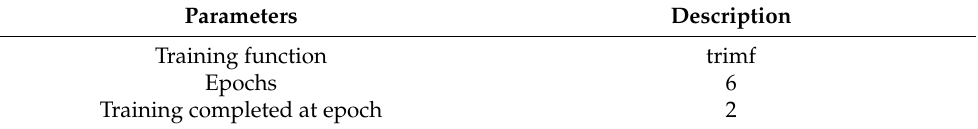
Table 5. Parametric adjustments for ANFIS .